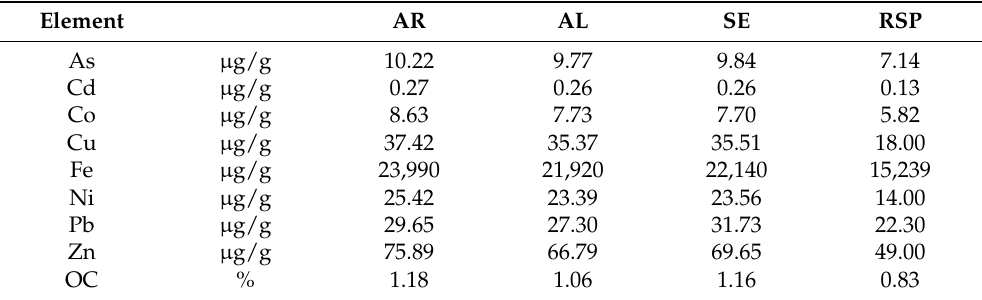
Table 1. Summarized results of chemical analyses in sediments from the studied stations (Adapted from